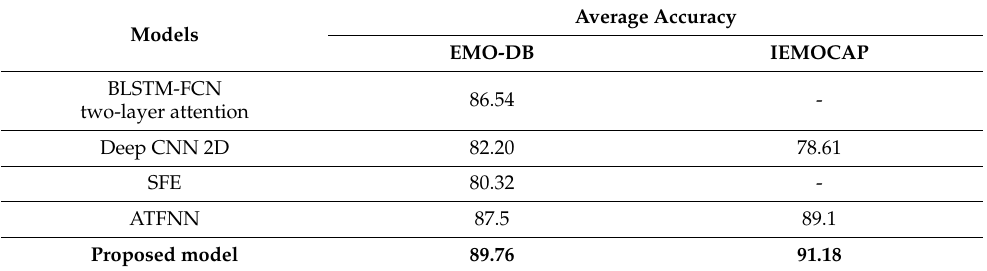
Table 3. Average accuracy comparisons between